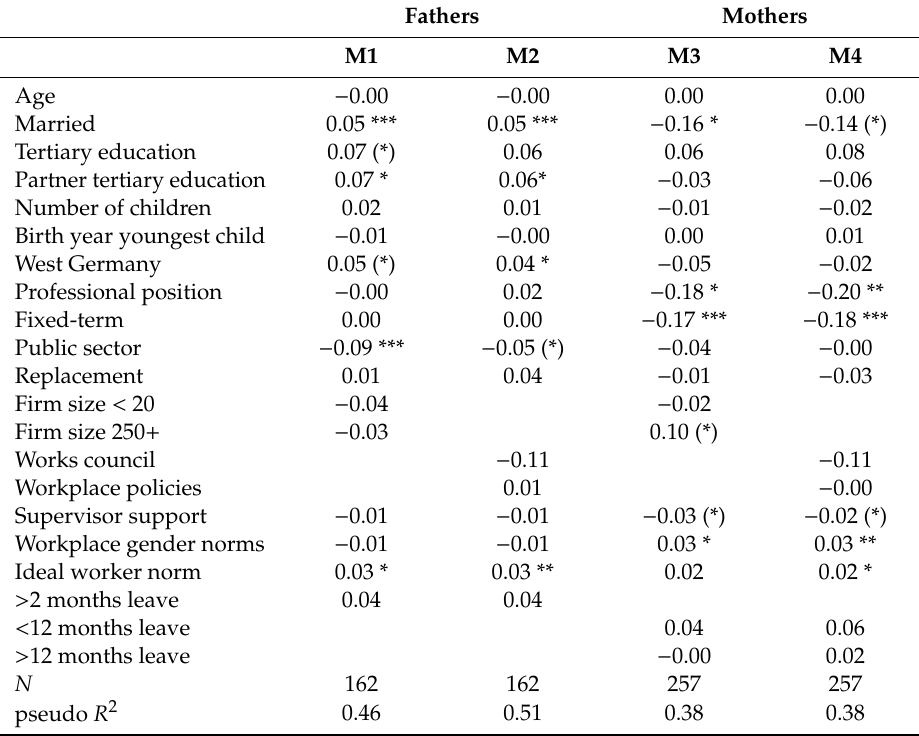
Table A6. Full model perceived career consequences of parental leave: logistic regressions, average marginal e ff